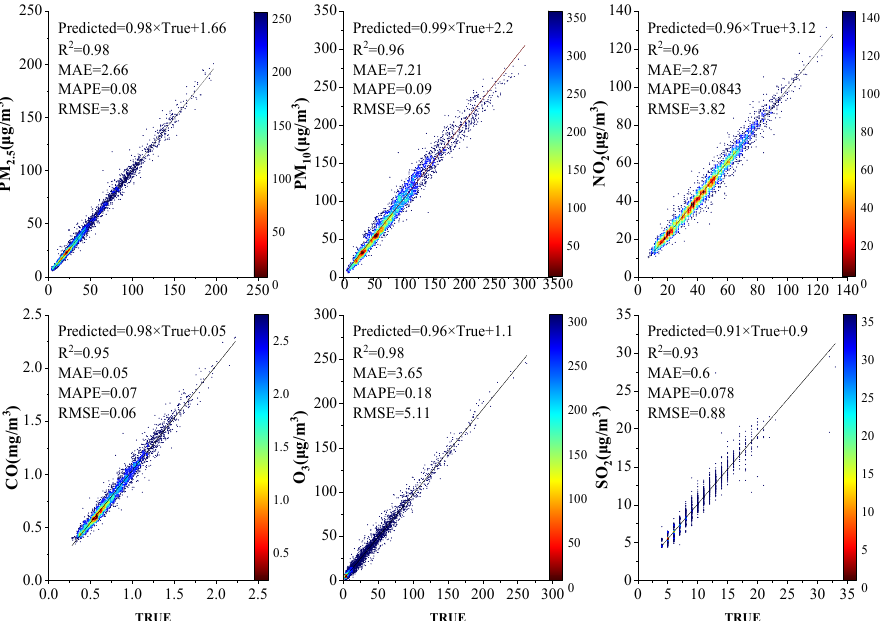
Figure 14. Comparison of actual and predicted values with meteorological and air pollutants added.